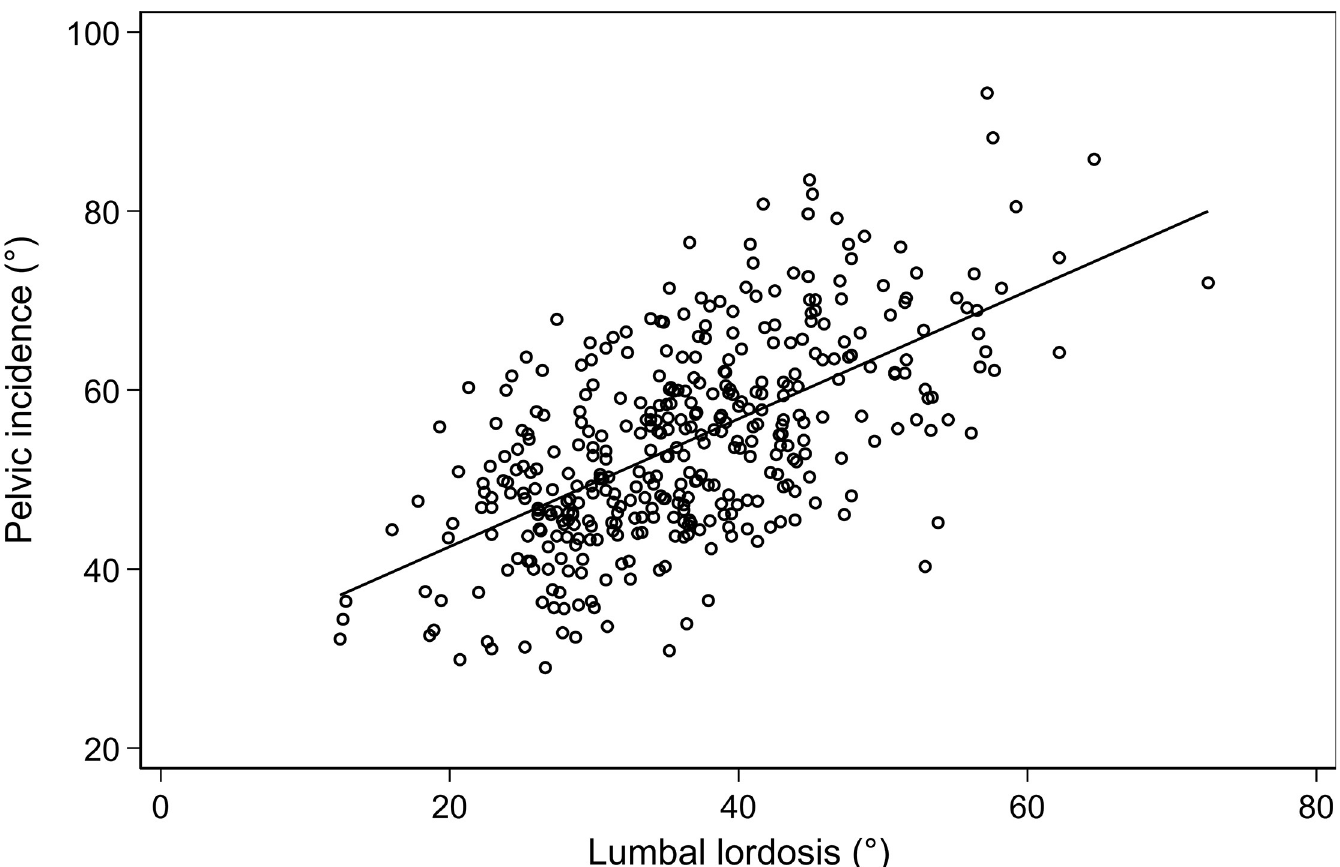
Fig 6. Correlation of pelvic incidence and lumbar lordosis, r = 0.614, p < 0.001.